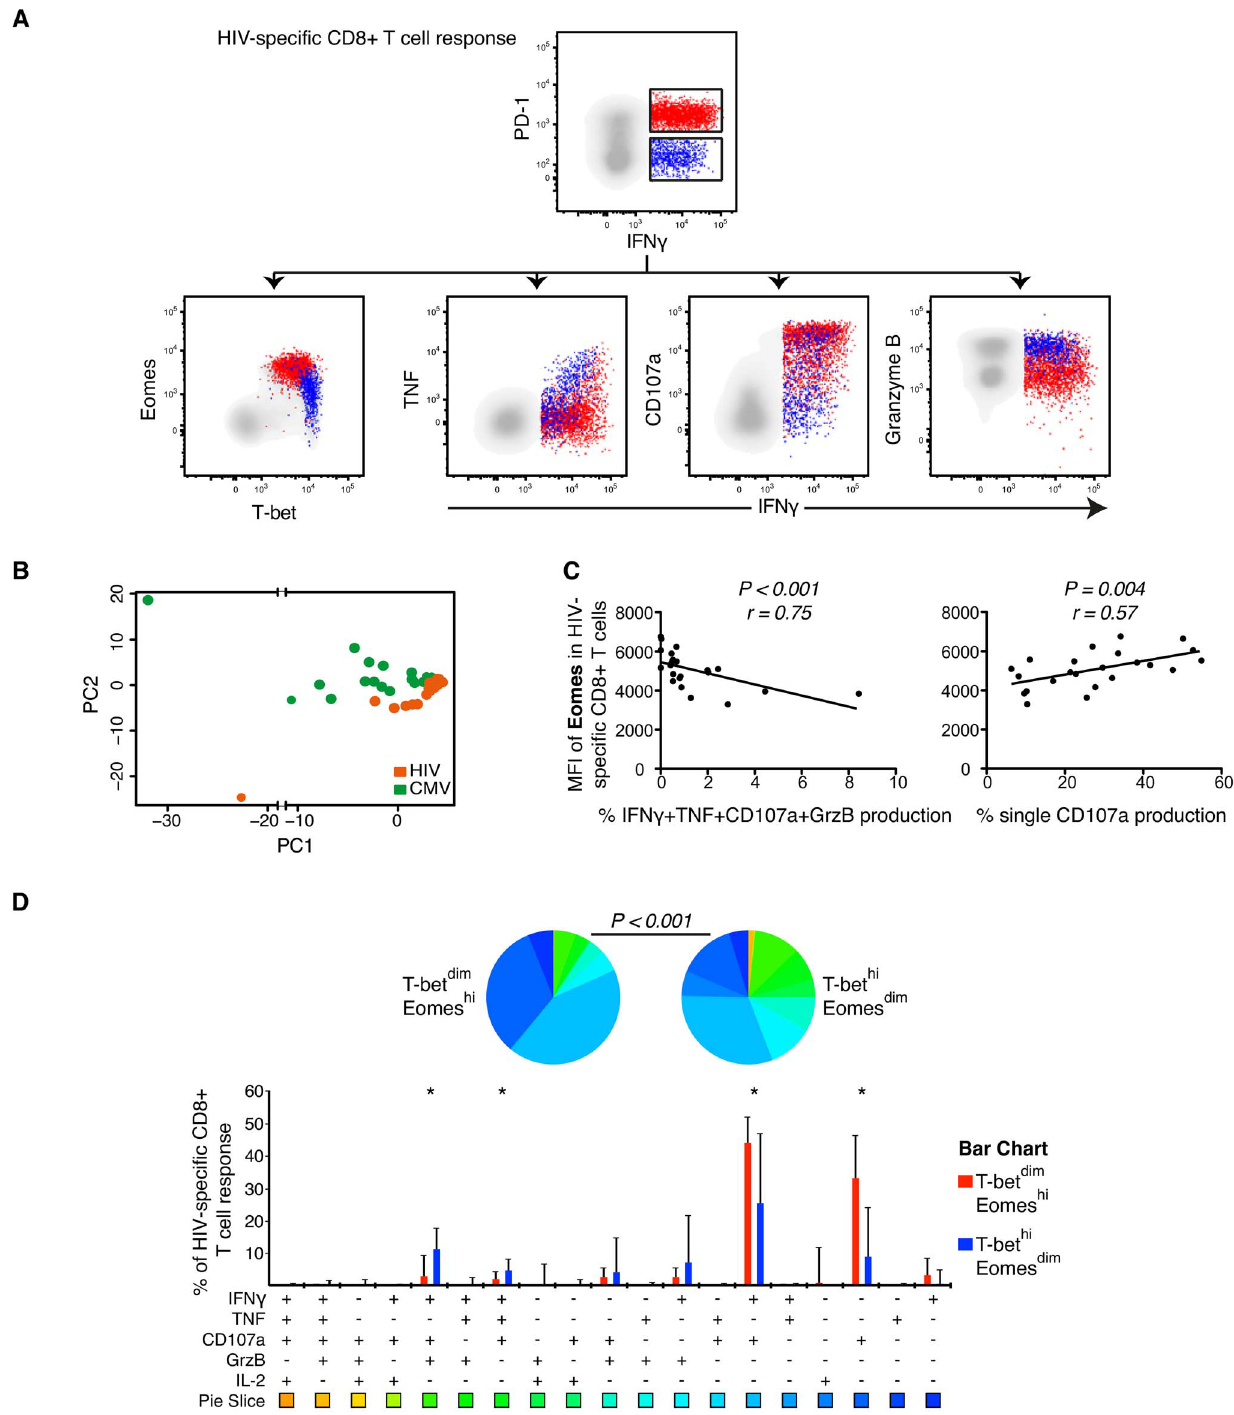
Figure 4. Polyfunctional characterization of virus-specific CD8 + T cells in untreated HIV-infected individuals. (A) Distribution of PD-1 + (red) and PD-1 2 (blue) HIV-specific CD8 + T cells within the T-bet/Eomes axis and linkage to IFN c and TNF, CD107a and Granzyme B expression. (B) Boolean combinations of all functional and inhibitory markers (n=256) were combined using PCA, generating a HIV- (orange) and CMV-specific (green) PC1 and PC2 score for each HIV infected subject (n=23). (C) Correlations between the MFI of Eomes and IFN c , TNF, CD107a and Granzyme B or single CD107a secretion. (D) SPICE analysis of all functional combinations between the T-bet dim Eomes hi (red) and T-bet hi Eomes dim (blue) population for HIV-specific CD8 + T cells. Median and IQR are shown for all bars and Wilcoxon matched-pairs single rank tests were performed to compare outcomes between groups; * P , 0.05. Functional combinations where the IQR did not exceed 1% are not depicted in the graph. Permutation test was performed between the pie charts.